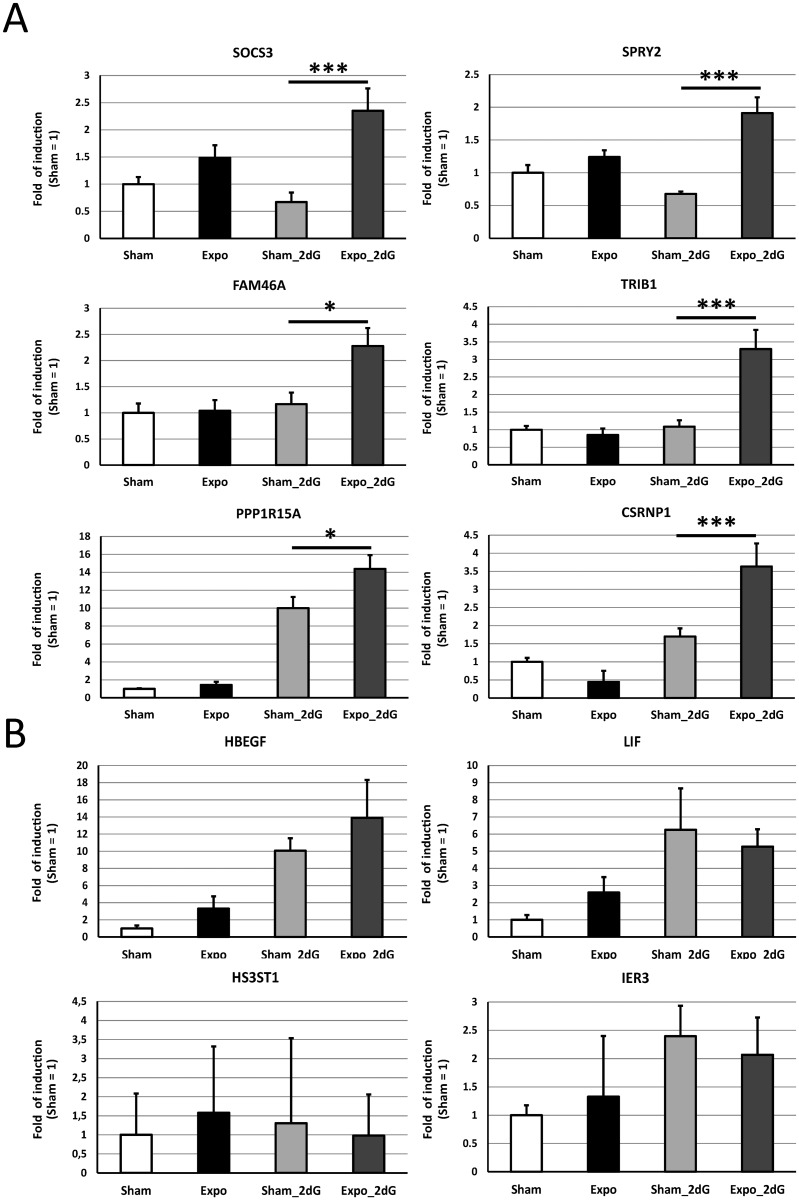
The gene expression profiles of the validated genes.Histograms represent the RT-qPCR data. The expression profiles were classified depending on their validation profiles as follows: (A) validated by RT-PCR or (B) not validated by RT-PCR.